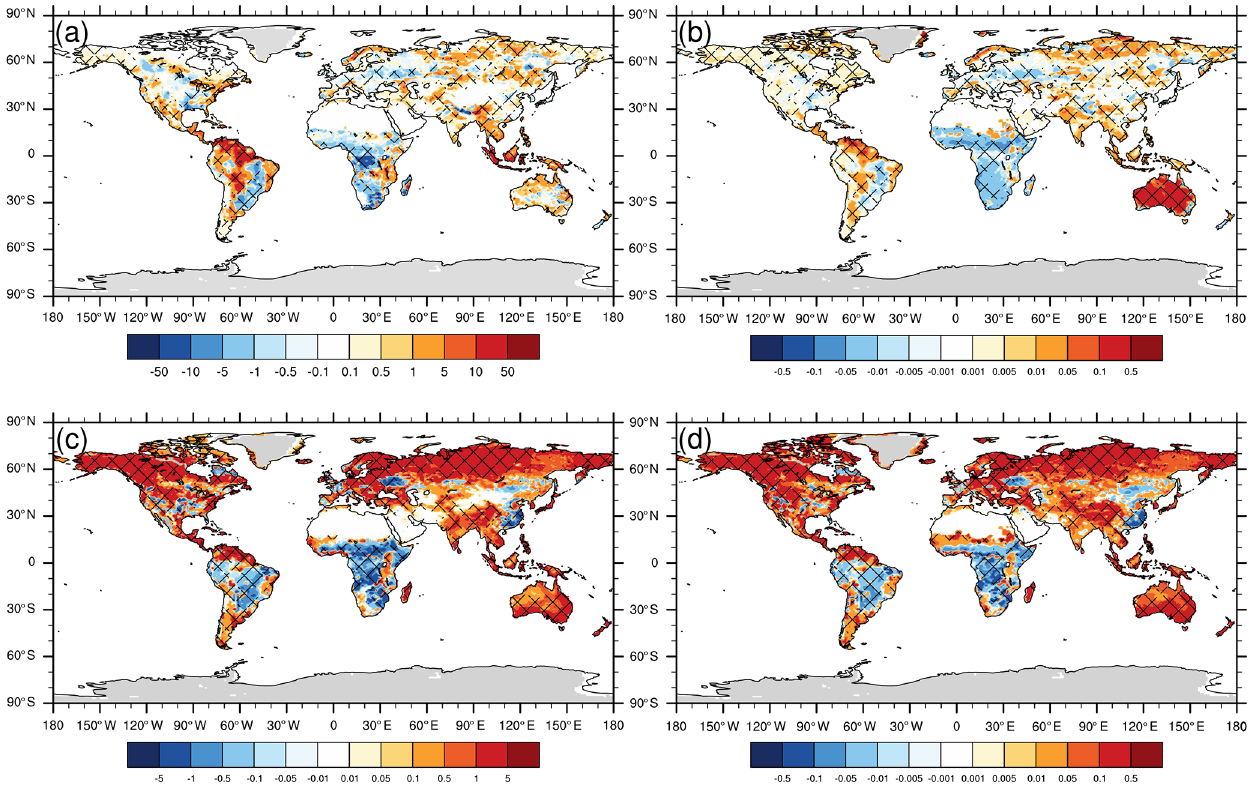
Figure 8. CESM-RESFire-simulated changes in fire-related variables between the RCP4.5 future scenario and the present-day scenario (CTRL2–CTRL1). (a) Changes in annual total fire ignition (NFIRE, 1 × 10 − 3 countkm − 2 yr − 1 ); (b) changes in annual average fire com- bustion factors (FCF, unitless); (c) changes in annual average fire spread rates (FSR_DW, cms − 1 ); (d) changes in annual average fire spread factors (FSF, unitless). The hatching denotes the 0.05 significance